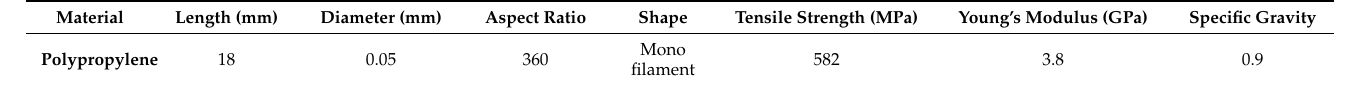
Table 2. Physical and mechanical properties of the